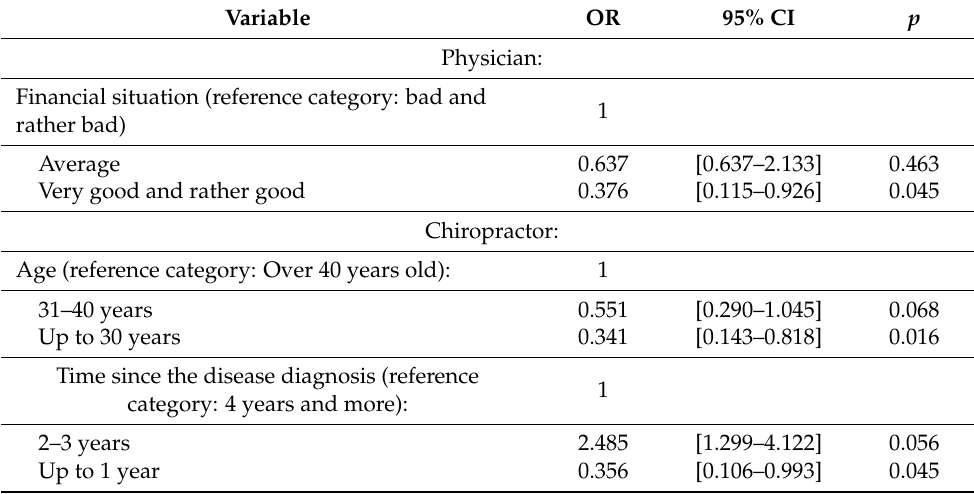
Table 3. Relationship between selected sociodemographic variables and use of services of comple- mentary and alternative